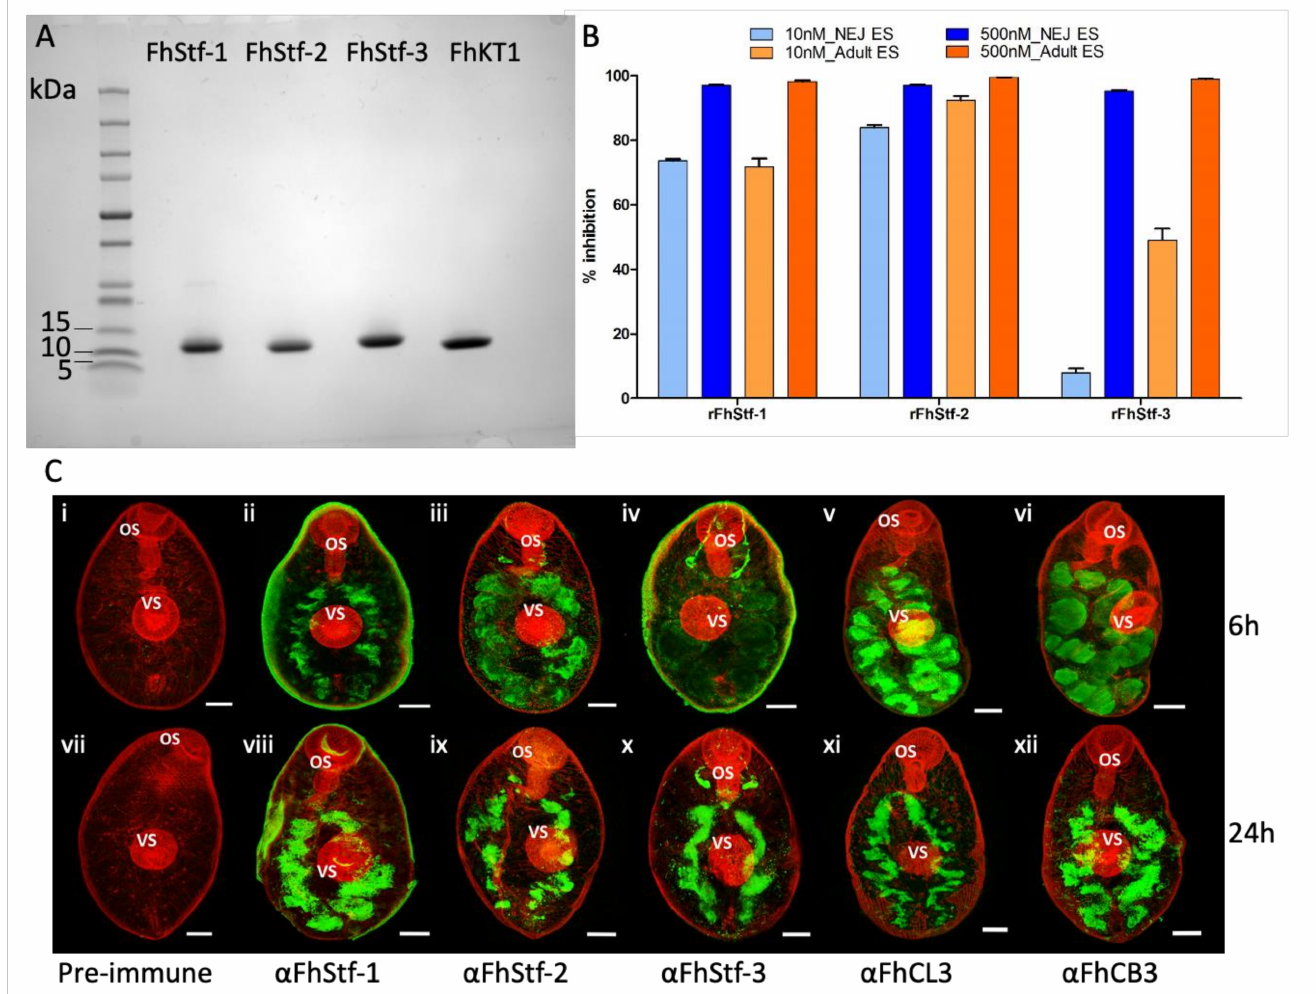
Figure 1. Characterisation of the Fasciola hepatica stefins. ( A ) Purification of the recombinant F. hepatica stefins and Kunitz-type inhibitors. 4–20% SDS-PAGE analysis of rFhStf-1 (lane 1), rFhStf-2 (lane 2) rFhStf-3 (lane 3) and rFhKT1 (lane 4). ( B ) Inhibition profiles of rFhStf-1, rFhStf-2 and rFhStf-3 against F. hepatica NEJ and adult ES products screened at 500 nM and 10 nM, relative to the cathepsin peptidase inhibitor E-64. E-64 inhibited the cathepsin peptidases within the ES products 100% (not shown on graph). Data represented at ± standard deviation of three replicates. ( C ) Immunolocalisation of FhStf- 1, FhStf-2 and FhStf-3 in NEJ at 6 h and 24 h post-excystment by confocal laser microscopy. Following excystment, NEJ were maintained in culture and sample parasites taken at 6 h post-excystment (panels i–vi) and 24 h post-excystment (panels vii–xii). Parasites were probed with rabbit pre-immune serum (i and vii), anti-FhStf-1 polyclonal antibodies (ii and viii), anti-FhStf-2 polyclonal antibodies (iii and ix), anti-FhStf-3 polyclonal antibodies (iv and x), anti-FhCL3 polyclonal antibodies (v and xi) or anti-FhCB3 polyclonal antibodies (vi and xii) followed by FITC-labelled secondary antibodies. FITC staining (green fluorescence) revealed FhStf-1, FhStf-2 and FhStf-3 proteins are located within the bifurcated gut at both time-points comparable to FhCL3 and FhCB3. All specimens were counter- stained with phalloidin-tetramethylrhodamine isothiocyanate (TRITC) to stain muscle tissue (red fluorescence) and provide structure. OS, oral sucker; VS, ventral sucker. Scale bars = 20 µ